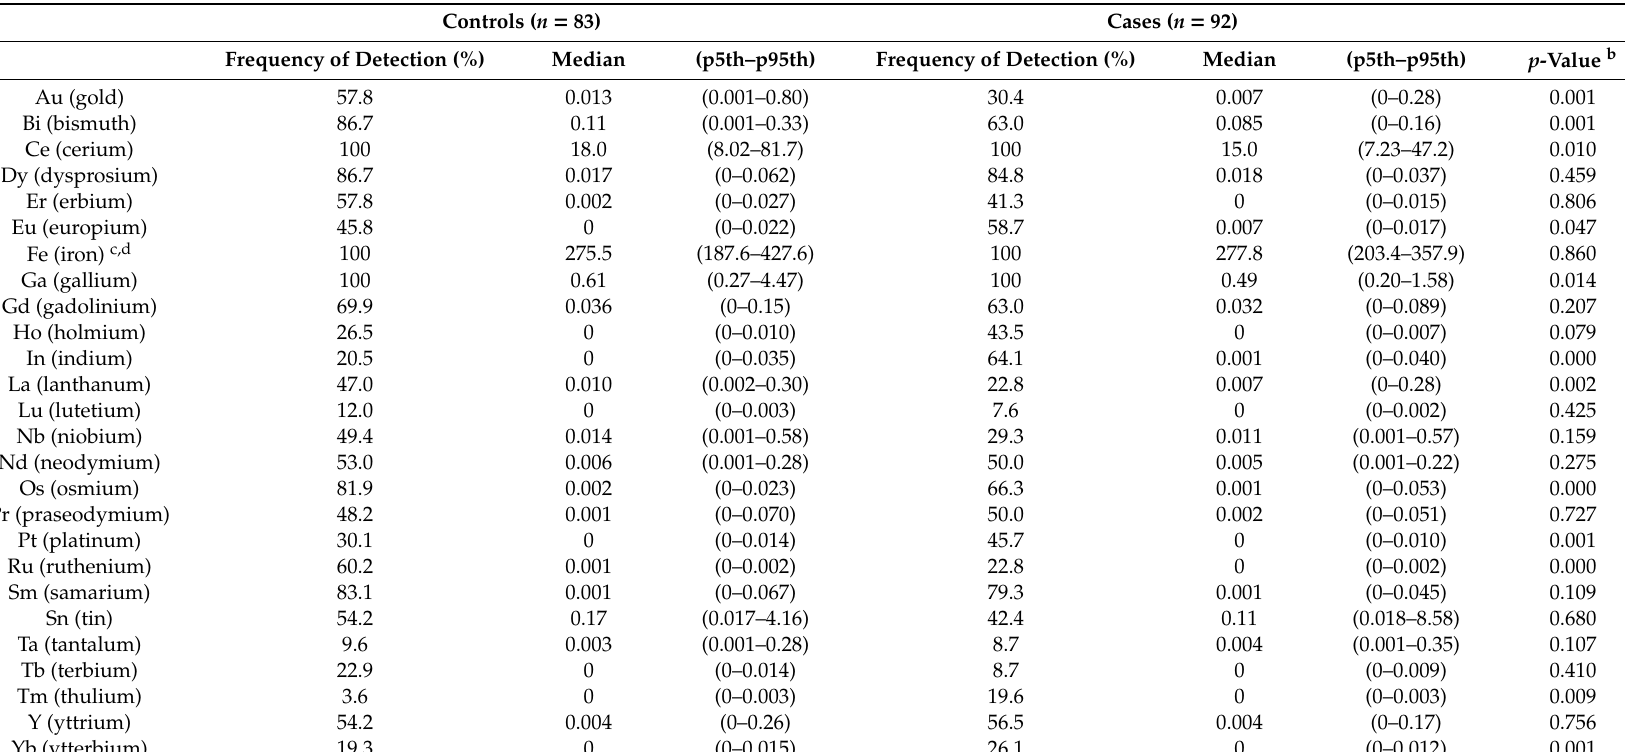
Table 4. Blood concentration (ng / mL) of rare earth elements (REE) and elements used in high tech devices a , among cases and